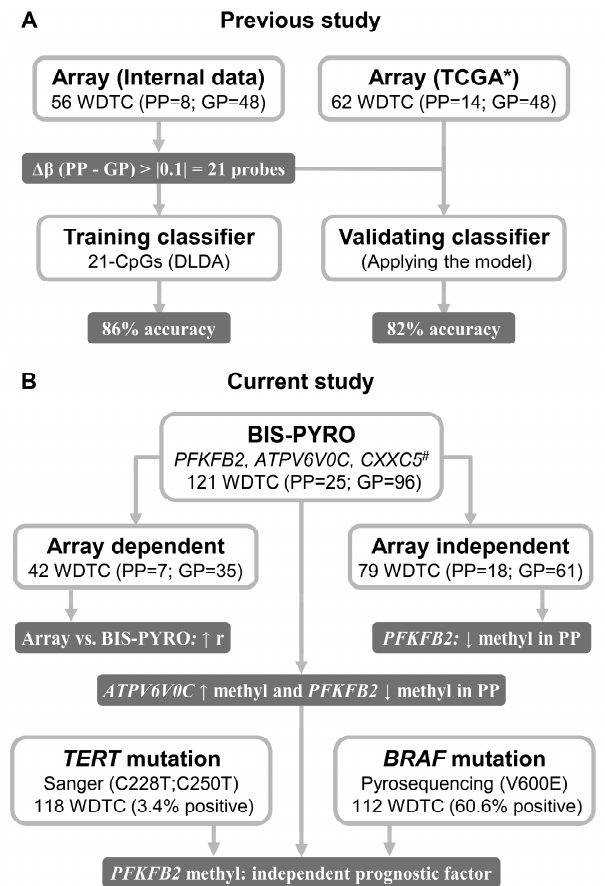
Figure 1. Workflow with the summarized study design and main results. ( A ) In the previous